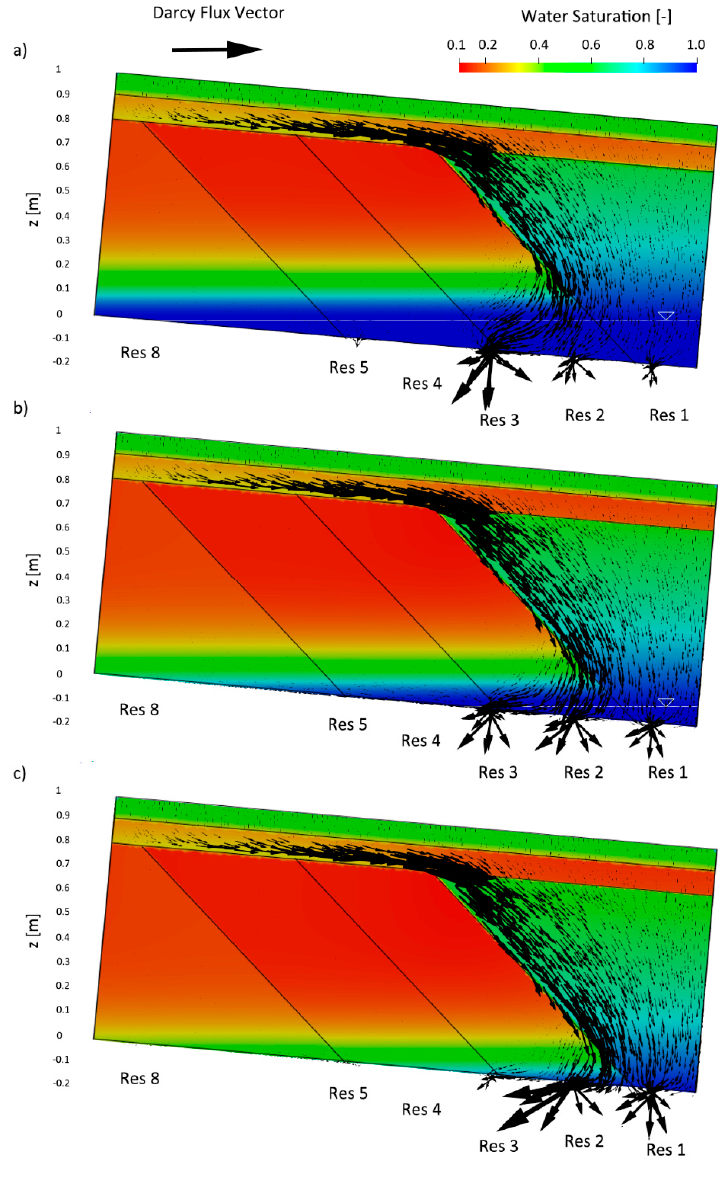
Figure A4. Simulated results of the flow models with a reduced infiltration rate: ( a ) water table as simulated for the flow model with the original infiltration rate (z ≈ − 2 cm); ( b ) water table lowered, located at z ≈ − 13 cm to represent the conditions for lower infiltration rates; and ( c ) no water table within the domain (pressure head negative at all outflow ports). Darcy flux vectors have been scaled 6-fold compared to Figures 4 and 6 for increased clarity. Flux vectors along the base demonstrate that changes in the water table location influence the outflow rates at the drainage ports depending on boundary conditions; however, the simulations also show that the results related to the functioning of the FCL and associated CBEs are not affected by the location of the water table.